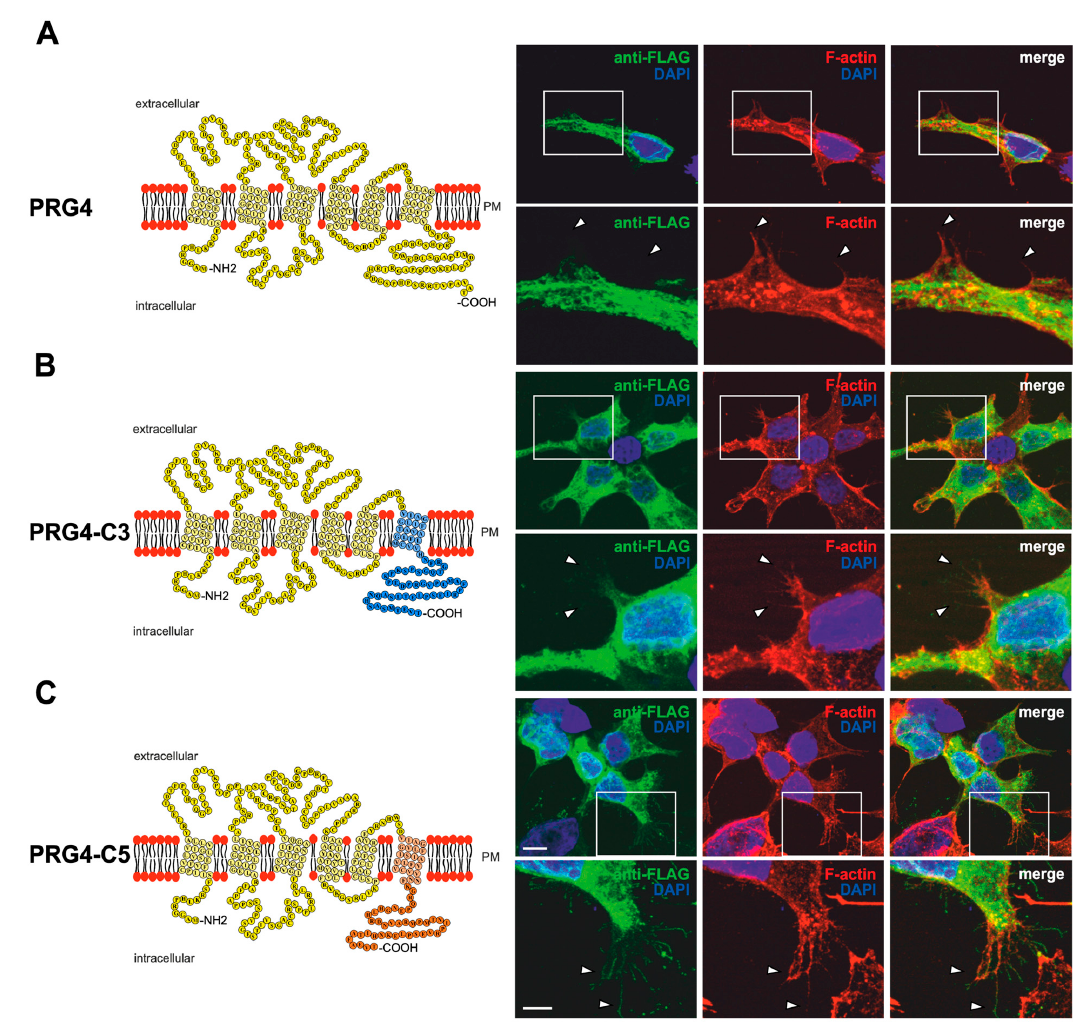
Figure 5. PRG3 and PRG5 C-terminal domains induce morphological changes when fused to PRG4 in non-neuronal cells. ( A ) Left panel: Schematic depiction of PRG4. Transmembrane domains TM1-TM6 are highlighted in light yellow, and the C- and N-terminal regions are located on the intracellular side. Single circles represent aa (one letter code). Upper right panel: Confocal stacks of representative HEK293H cells transfected with PRG4-encoding plasmids and stained for FLAG. Arrowheads point to filopodia identified by F-actin staining (red, phalloidin). This refers also to ( B ) and ( C ) . PM = plasma membrane. Lower right panel: Higher magnification of representative HEK293H cells transfected as above and indicated by white rectangles. ( B ) Left panel: Schematic depiction of PRG4-C3. The sequence of exchanged C-terminal domain residues of PRG3 is shown in blue (aa 257–325; including TM6). Right upper panel: Confocal stacks of representative HEK293H cells transfected with PRG4-C3-encoding plasmids and stained for GFP. Lower right panel: Higher magnification of representative HEK293H cells transfected as above and indicated by white rectangles. ( C ) Left panel: Schematic depiction of PRG4-C5. The sequence of exchanged C-terminal domain residues of PRG5 is shown in orange (aa 252–316; including TM6). Upper right panel: Confocal stacks of representative HEK293H cells transfected with PRG4-C5-encoding plasmids and stained for GFP. Lower right panel: Higher magnification of representative HEK293H cells transfected as above and indicated by white rectangles. Cell nuclei were stained with DAPI (blue). The scale bar represents 10 µ m in the upper panels and 5 µ m in the lower